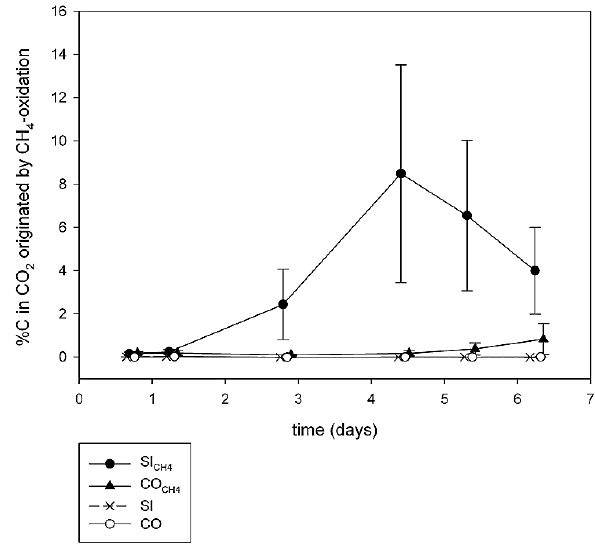
Fig. 1. Percentage of C incorporated into CO 2 originated from CH 4 at different time points ( f CH soil with methane (SI CH and treatments without methane (SI, CO). Results are presented as means ± standard deviation ( n = 8 for SI CH for SI and